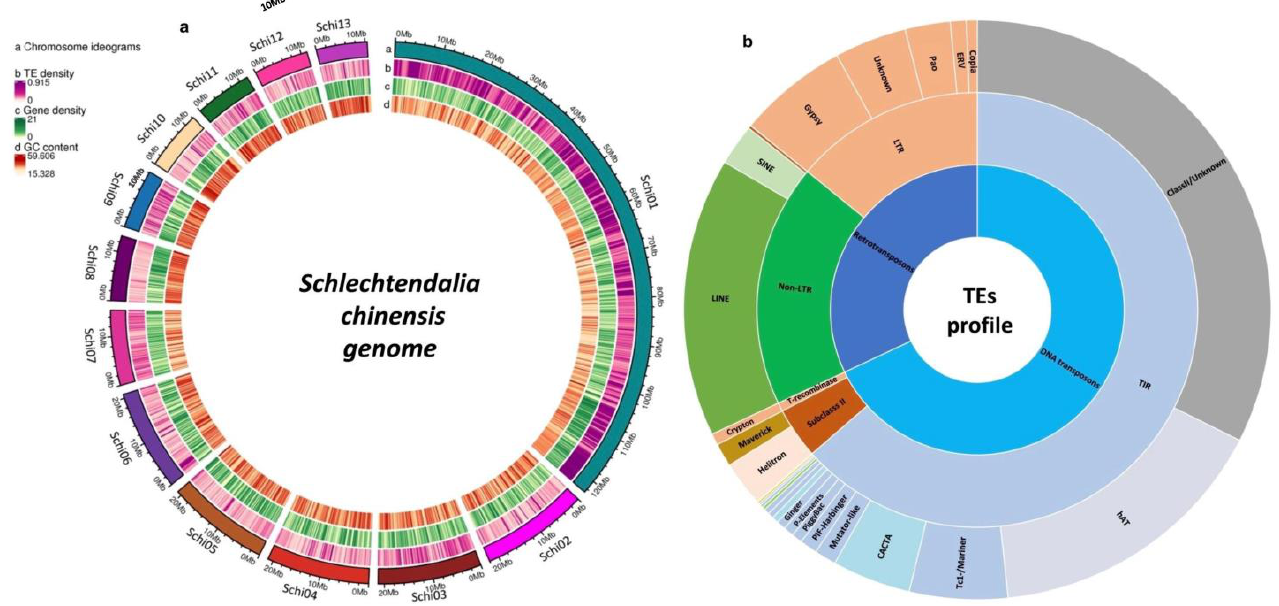
Figure 1. TEs ’ distribution in the genome of Schlechtendalia chinensis . ( a ) Showing TE density in the 13 chromosomes of S. chinensis . ( b ) Showing TE classification and contribution to the genome size.